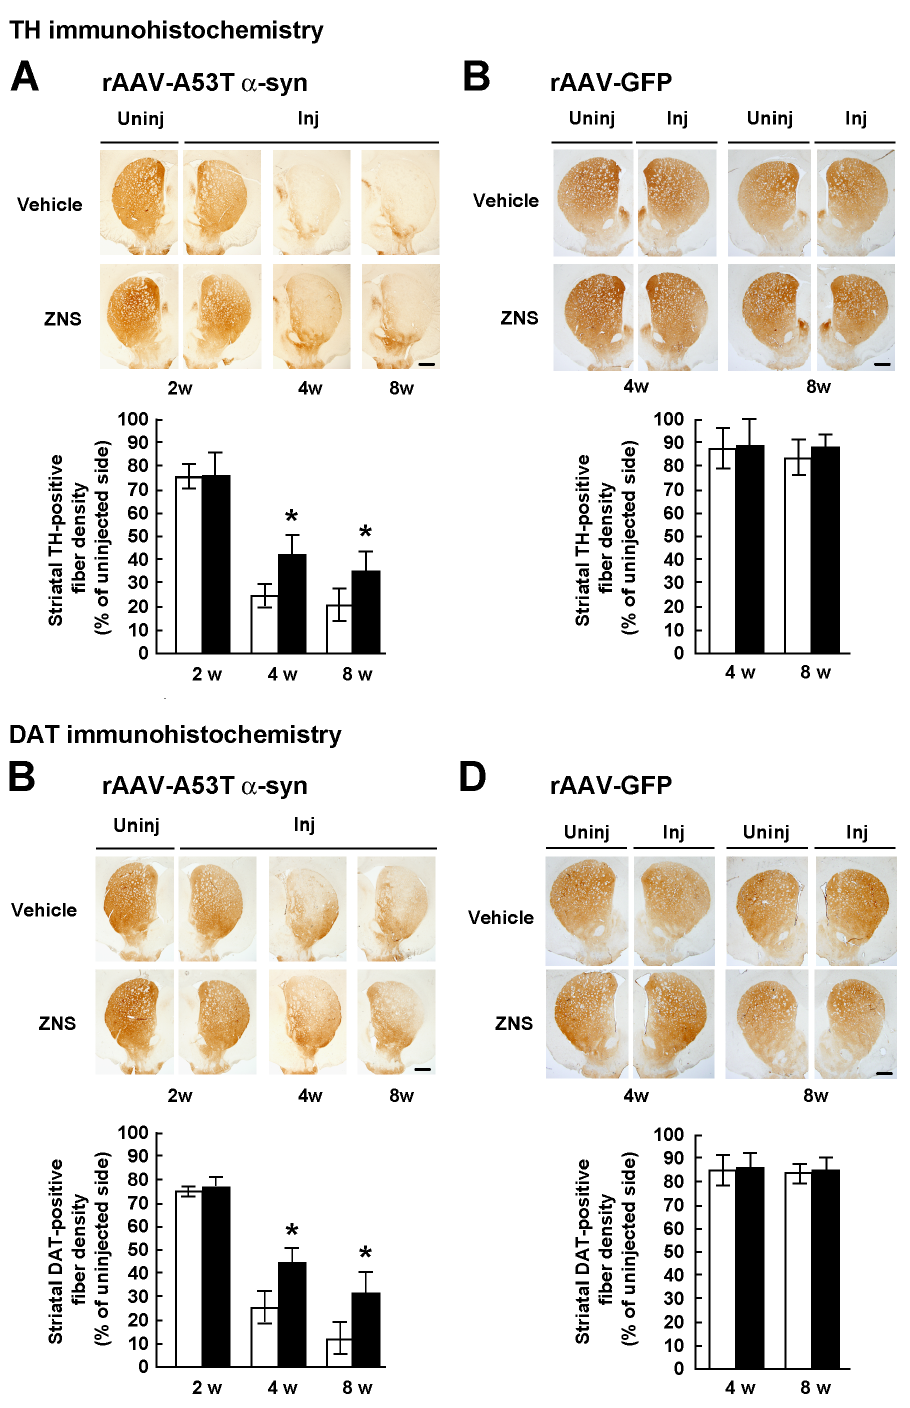
Figure 3. Semiquantification of the optical densities of striatal dopamine nerve terminals in rats treated with vehicle or ZNS. Rats were unilaterally injected with rAAV-A53T a -synuclein ( A , C ) or rAAV-GFP ( B , D ). The sections were immunostained with antibody for TH ( A , B ) or DAT ( C , D ). In rats injected with rAAV-A53T a -synuclein ( A , C ), photomicrographs show representative immunostainings of the injected and uninjected sides of the substantia nigra at 2 weeks after injection (left panels), and those of the injected sides at 4 weeks (middle panels) and 8 weeks (right panels) after injection. In rats injected with rAAV-GFP ( B , D ), photomicrographs show representative immunostainings of the injected and uninjected sides of the substantia nigra at 4 weeks (left panels) and 8 weeks (right panels) after injection. Scale bars, 1.0 mm. ( A–D ) Graphs show semiquantitative analysis of striatal TH or DAT-positive fibers. As compared with the vehicle group, ZNS significantly suppressed loss of striatal TH- positive fibers at 4 weeks ( P , 0.001) and 8 weeks ( P =0.004) after rAAV-A53T a -synuclein injection. Decreased densities of DAT-positive fibers were significantly suppressed in the ZNS group at 4 weeks ( P , 0.001) and 8 weeks ( P , 0.001) after viral injection. The open bars illustrate the vehicle group and the black bars illustrate the ZNS group. Data represent the mean 6 SD and P -values were estimated by two-way ANOVA, followed by a Bonferroni’s post hoc test (* P , 0.05).